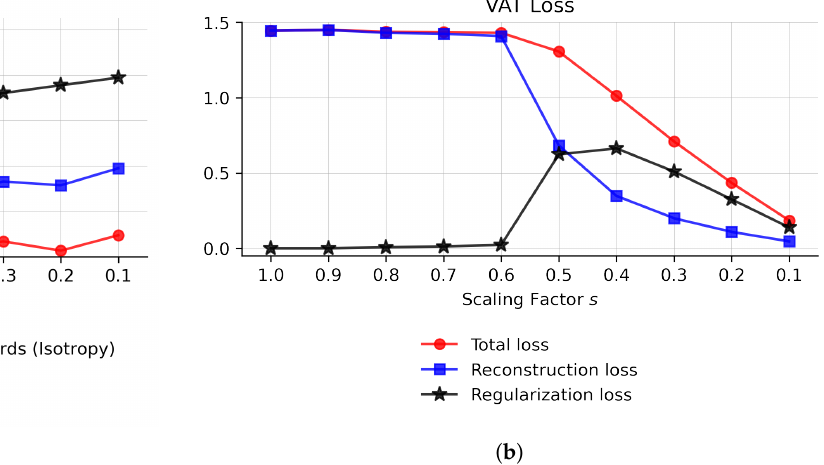
Figure 3. Optimizing the scaling factor s with respect to isotropy and loss values. ( a ) Cosine similarities of the latent representations of the VAT at the end of the training process denoting the isotropy of the latent space and the contextuality of token representations; ( b ) reconstruction loss, weighted regularization loss, and total loss of the VAT at the end of the training